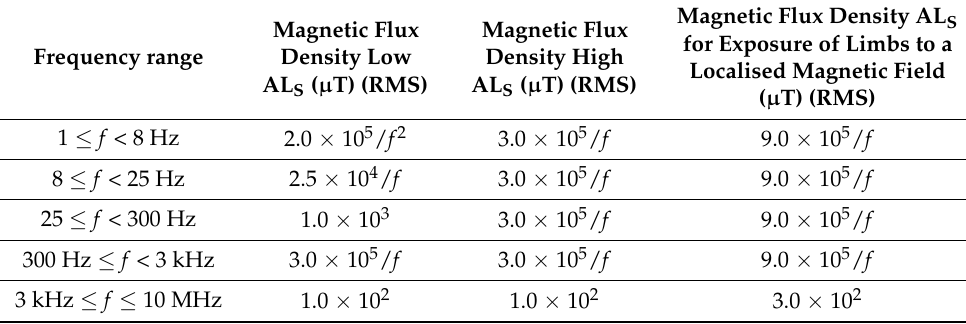
Table 1. European Directive 2013/35/EU—Action Levels for exposure to magnetic fields from 1 Hz to 10